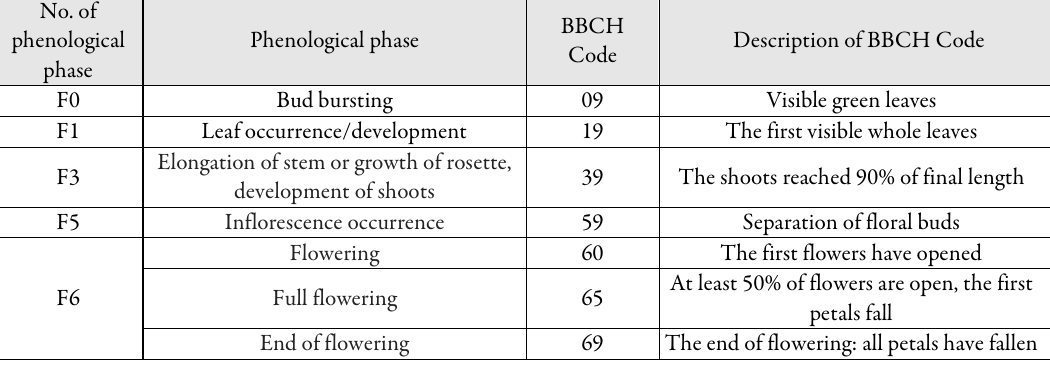
Table 1. Description of spring phenophases recorded in ornamental species based on the BBCH